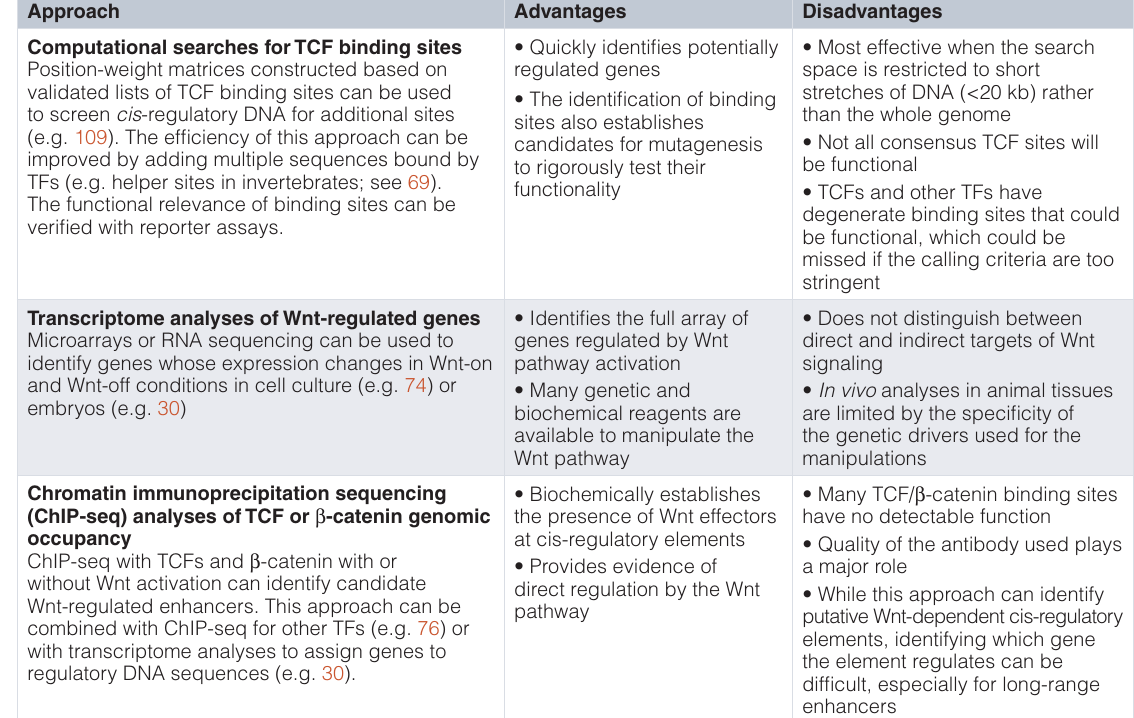
Table 1. Approaches to identify Wnt target genes directly activated by the pathway. We define “direct Wnt targets” as genes whose regulatory DNA can be physically associated with T-cell factors (TCFs) or other transcription factors (TFs) and whose expression is modulated by the recruitment of β -catenin to regulatory chromatin by these TFs. The approaches outlined below each have their advantages and disadvantages, and a combination of them is required to establish with confidence that a gene is a Wnt target gene in a particular